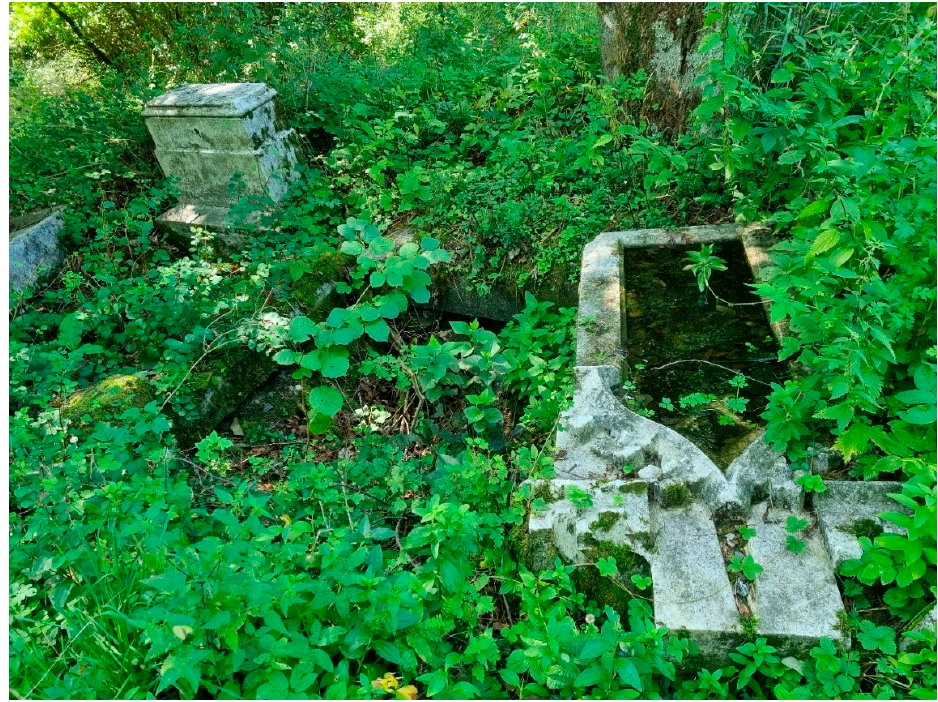
Figure 7. Torso of cemetery tombstones. Milovany (Milbes), military training area Libavá.